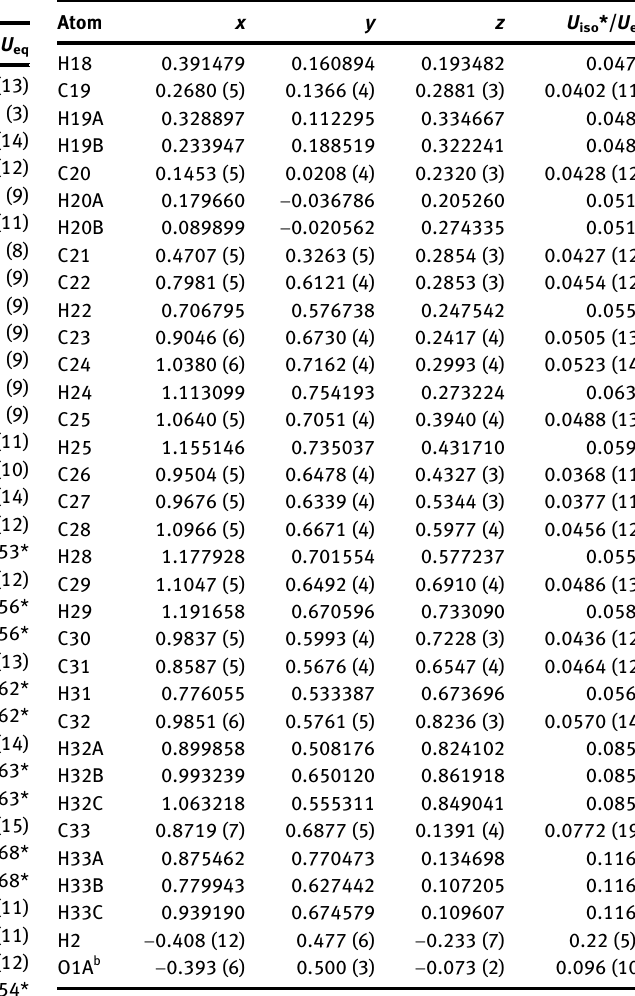
Table  : Fractional atomic coordinates and isotropic or equivalent isotropic displacement parameters (Å 